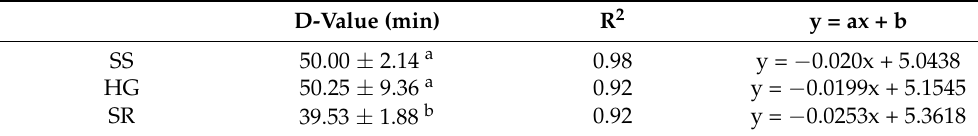
Figure 1. Survival curves of Listeria monocytogenes biofilm in stainless steel treated by DBD plasma using the first-order kinetic model. The data were represented by the mean ± standard deviation of the three independent replicates. a–d Values marked with different letters within each treatment are significantly different by Duncan’s multiple range test ( p < 0.05). Table 1. Effect of DBD plasma treatment on D-values of L. monocytogenes mixed-culture biofilm, and reduction by first-order kinetics model in the SS, HG and SR.